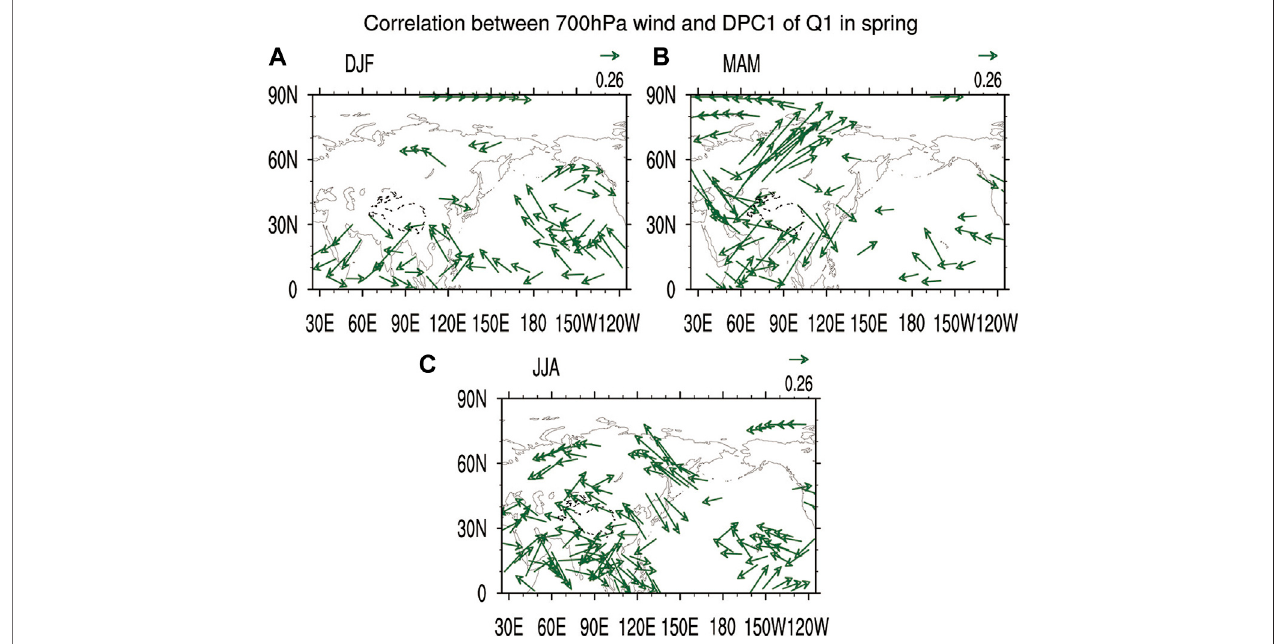
FIGURE 12 | Vector resultants (arrows) of correlation coef fi cient between DPC1 and 700 hPa zonal and meridional wind in the time period 1979 – 2020 in (A) previous winter, (B) spring and (C) summer. A positive correlation for zonal or meridional wind is denoted by an eastward or poleward arrow, respectively. Arrows are shown only when the statistical signi fi cance at the 90% con fi dence level for the correlations of zonal wind.